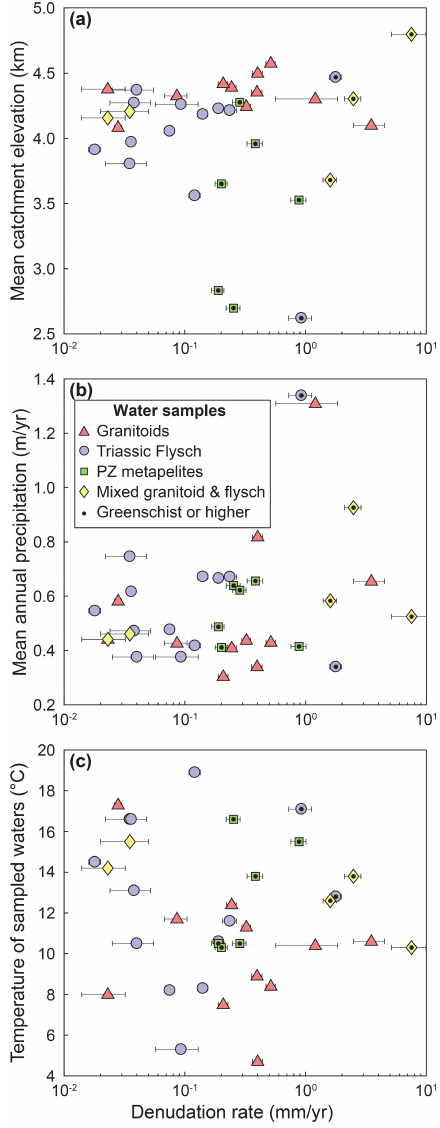
Figure 2. Variability of topographic and climatic parameters across the denudation gradient. (a) Catchment-averaged elevation up- stream of each sample as a function of denudation rate. (b) TRMM- derived mean annual precipitation in the catchment as a function of denudation rate. (c) Temperature of sampled waters as a function of denudation rate. Catchments underlain by different lithologies are distinguished by symbols and color. Data points with a black dot are metamorphosed to greenschist facies or